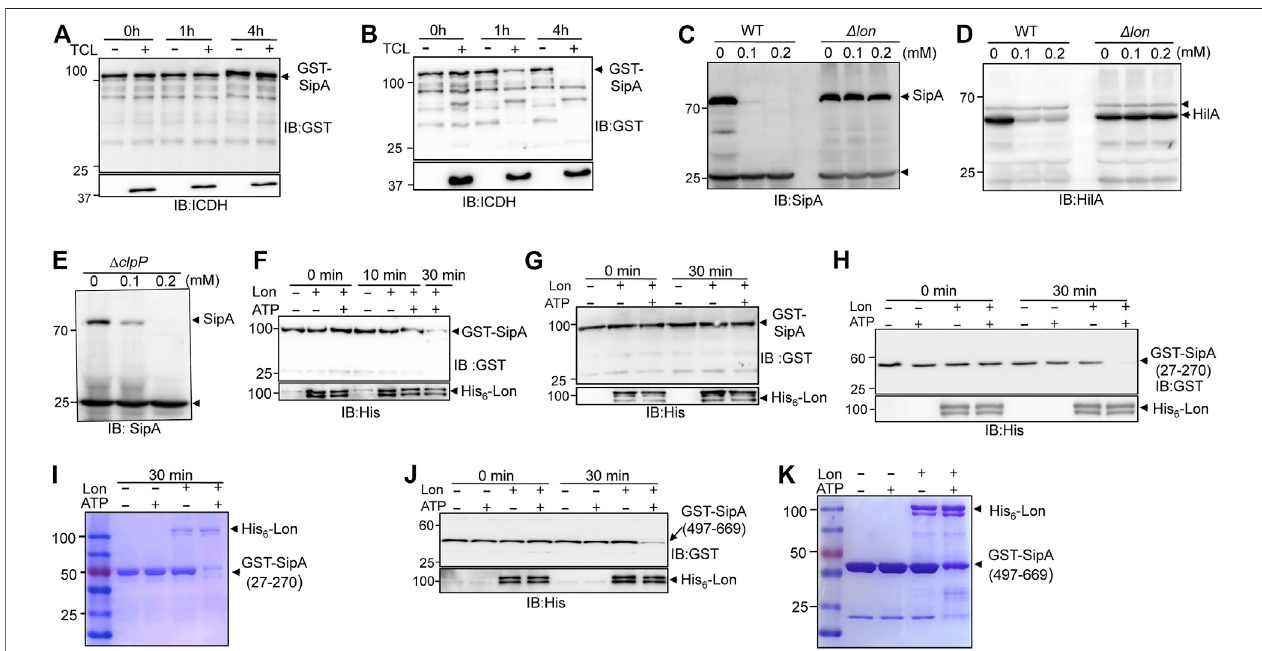
FIGURE4 | Lonprotease degrades proteins targeted bythymol. (A,B) Degradation ofSipA expressed in thepresence ofthymol bycell lysates of S. Typhimurium. GST-SipA puri fi ed from cultures containing thymol or its solvent was added to total cell lysates (TCL) of S. Typhimurium. Reactions terminated at the indicated time by SDSsamplebufferwereprobedforthefusionproteinbyimmunoblotting.ICDHinthereactionswasprobedtoindicatethepresenceofequalamountsofTCLinrelevant reactions. (C – E) TheLonbutnottheClpPproteaseisrequiredforthymol-induceddegradationofSipAin S. Typhimurium.Totalproteinsofwildtype,the lon (C,D) , or the clpP mutant (E) of S. Typhimurium grown in the presence of thymol or its solvent resolved by SDS-PAGE were probed for SipA or HilA by immunoblotting. Note that in the clpP mutant, thymol still caused robust reduction in SipA. The arrows indicate the bands nonspeci fi cally recognized by the antibodies that serve as loading controls. (F,G) Lon only degrades GST-SipA from cells that have been exposed to thymol. GST-SipA puri fi ed from cultures supplemented with thymol (F) or its solvent (G) was mixed with His 6 -Lon, and ATP was added to a subset of samples to initiate the reactions. Reactions terminated at the indicated time points resolved by SDS- PAGEwere probed for thefusion protein. 10% ofthe samples wereprobed forHis 6 -Lon (lower panels). (H – K) The degradation ofGST-SipA 27-270 and GST-SipA 497-669 by Lon. GST-SipA 27-270 and GST-SipA 497-669 puri fi ed from cultures grown in the presence of thymol were mixed with His6-Lon, and ATP was added to a subset of reactionstoinitiatetheactivity.ProteinsofinterestinreactionsterminatedattheindicatedtimepointsresolvedbySDS-PAGEwereprobedbyimmunoblotting (H,J) orby Coomassie bright blue staining (I,K) . The experiments were repeated at least three times each with independent biological